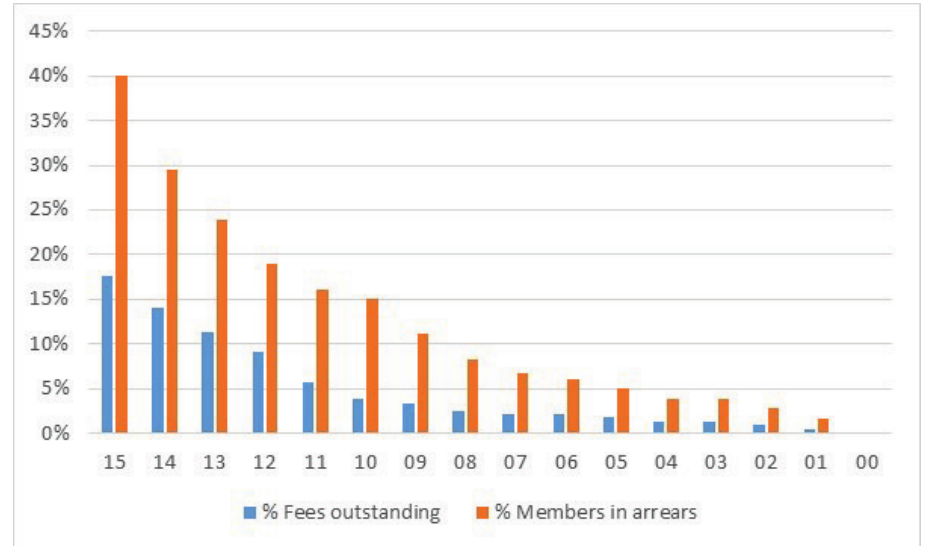
Figure 3: Percentage of fees outstanding and members in arrears by year,